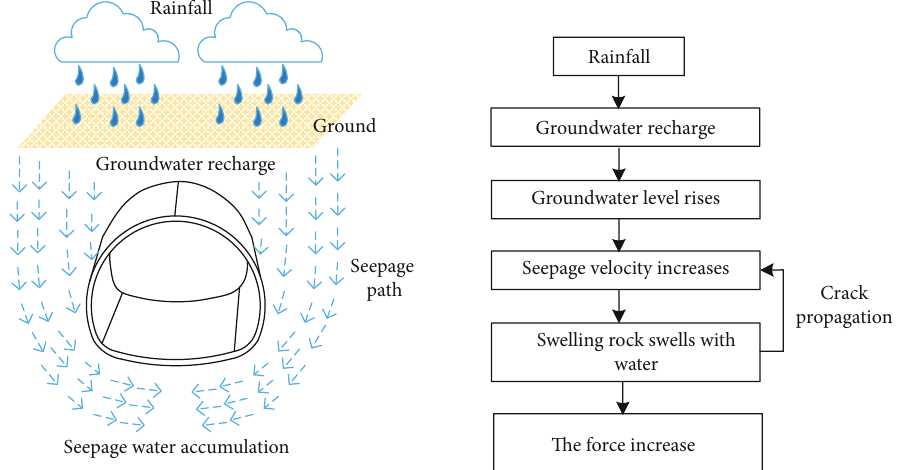
Figure 9: Process for increasing stress from the seepage water accumulation.